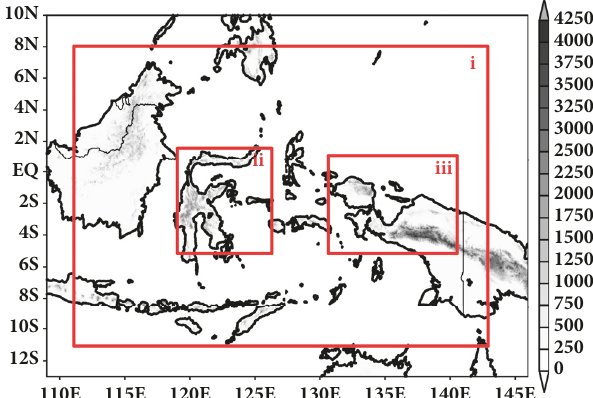
Figure 1: WRF-ARW nesting domain setting with (i) first domain resolution of 27km, (ii) second domain resolution of 9 km rep- resenting Tolo Bay, and (iii) third domain resolution of 9 km representing Cenderawasih